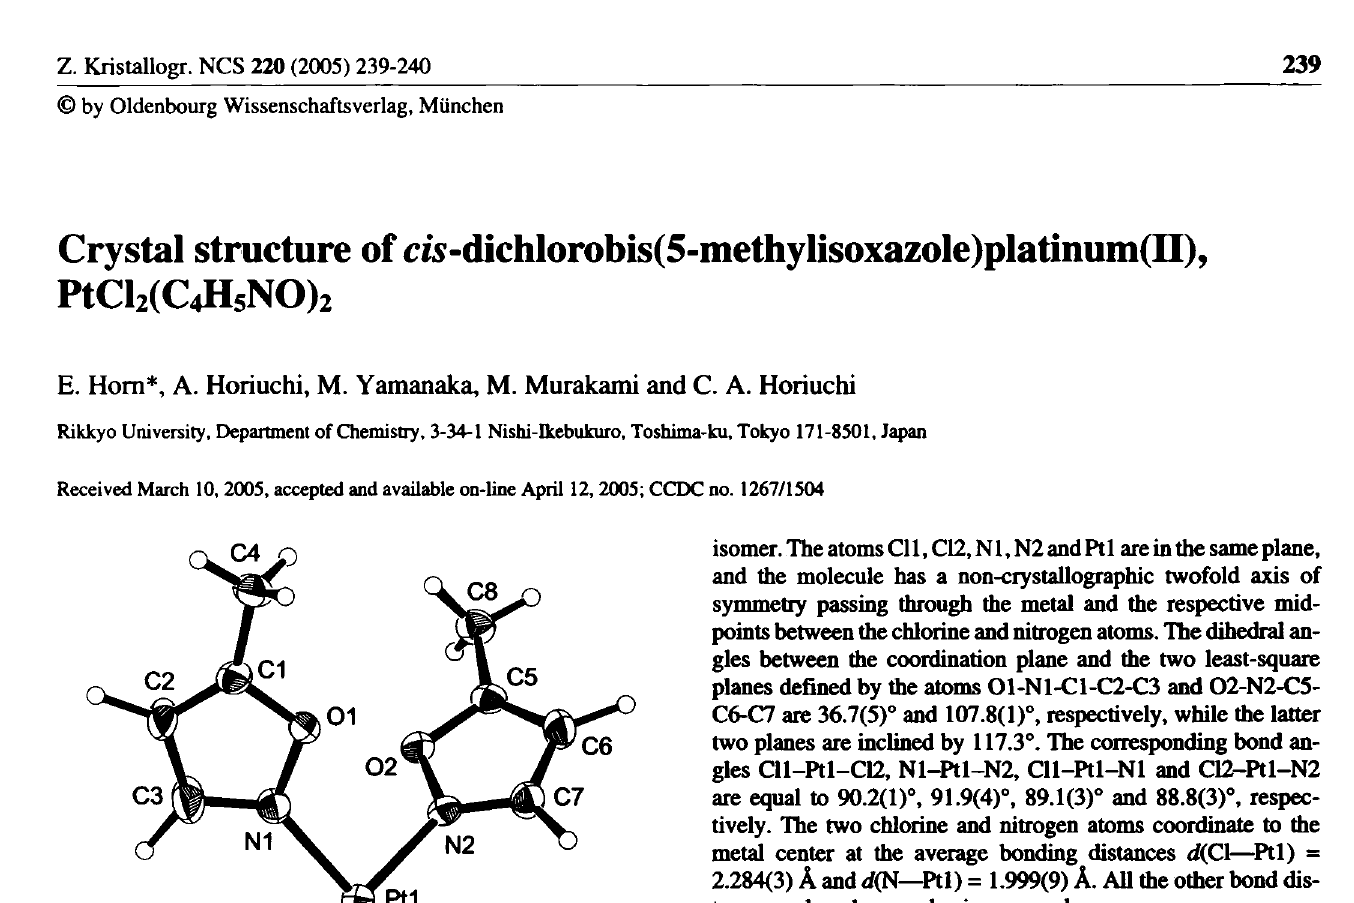
Table 1. Data collection and handling.